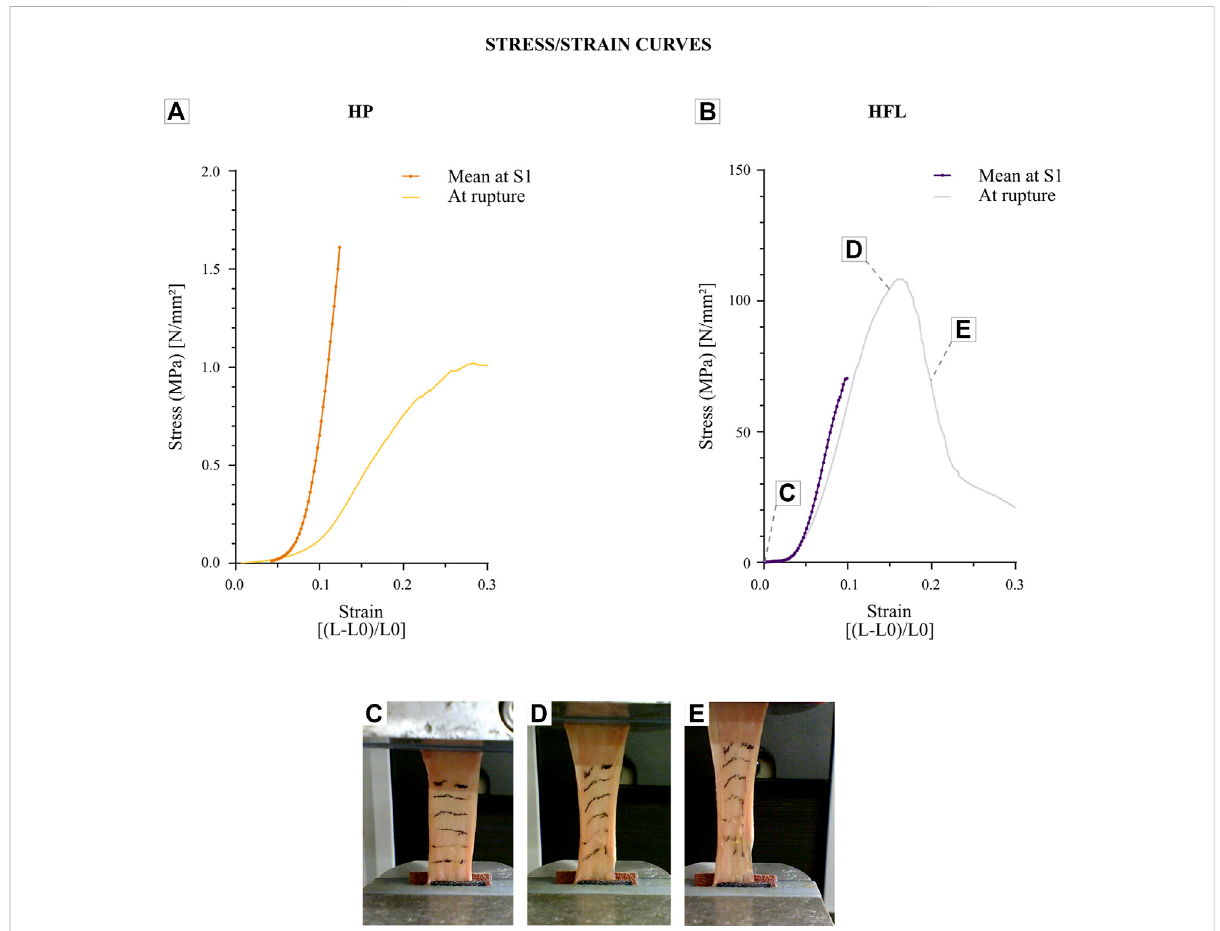
FIGURE 11 Stress/strain curves for periosteum ( N = 6 donors x one strip from each donor leading to n = 6 specimens analyzed for each speed) (A) compared to the fascia lata ones ( N = 11 donors x fi ve strips from each donor leading to n = 55 specimens analyzed for each speed) (B) . Graphs illustrate each average curve at S1 of all donors and provide an example of stress/strain curve of one donor for each tissue until the rupture. HP: human periosteum, HFL: human fascia lata, L: fi nal length, L0: initial length. Fascia lata deformation during a tensile test from the beginning (C) , at 15% of deformation (D) , and until the rupture (E) , which is also registered on the fascia lata stress/strain curve.